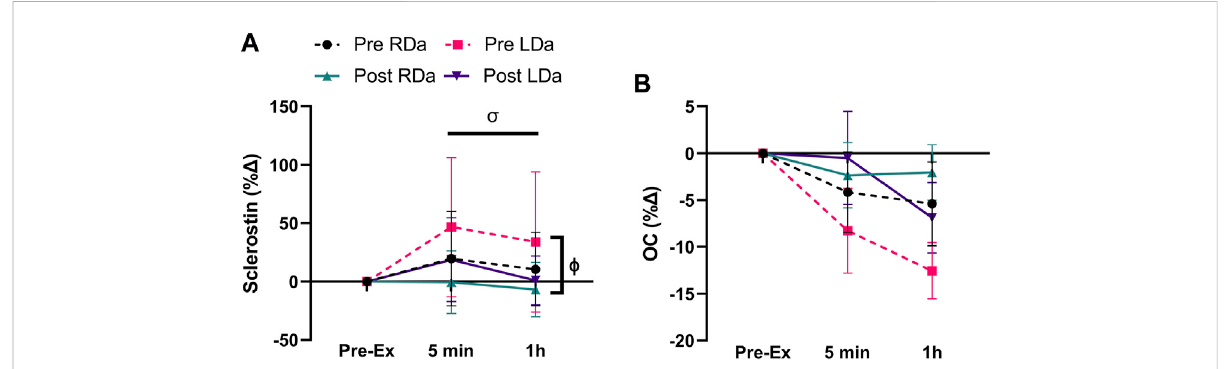
FIGURE 1 Serum sclerostin and osteocalcin (OC) percent change to acute exercise at pre- and post-intervention in both RDa and LDa groups: percent change of serum sclerostin (A) and OC (B) at 5 min and 1 h post-exercise relative to pre-exercise in both RDa ( n = 14) and LDa ( n = 16) groups. σ = main effect for time ( p < 0.05) independent of intervention or group. ϕ = main effect for intervention ( p < 0.05) independent of group. Data are reported as mean ±